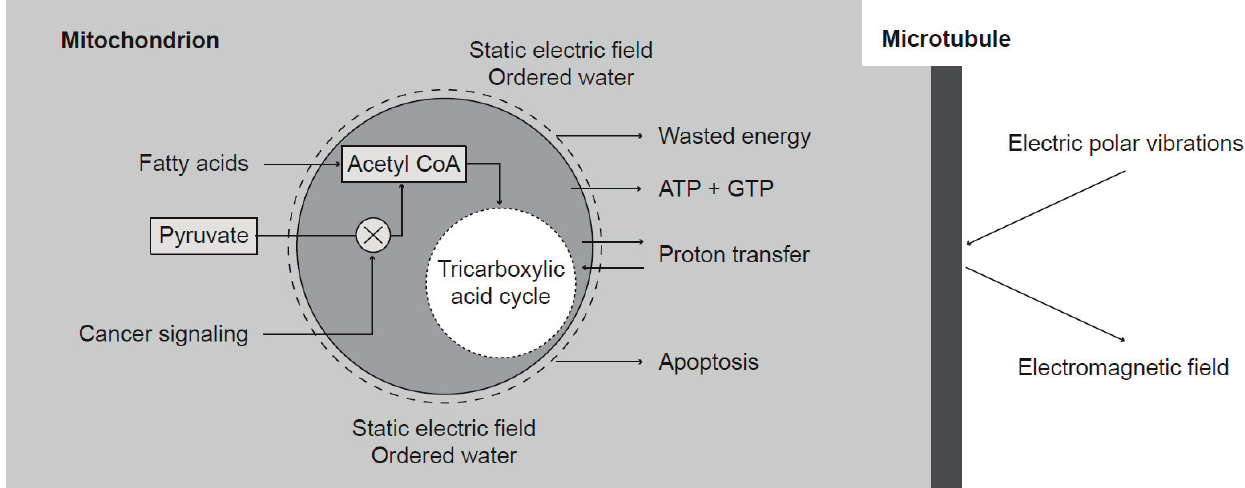
Figure 3. Transformation of the biochemical disturbance along the cell transformation pathway into the biophysical pathological states. Mitochondria transport protons into the intermembrane space, and their diffusion into cytosol leads to generation of a strong static electric field and water ordering. The strong static electric field shifts also vibrations in microtubules into a highly nonlinear region. The decrease of oxidative metabolism results in changes of the intensity of the static electric field and changes of water ordering. The water ordering depends on pH factor and also on the static electric field (Figure 1). Energy is supplied to microtubules by hydrolysis of GTP upon β -tubulin polymerization, through motion of motor proteins, and by nonlinear transfer from the higher frequency